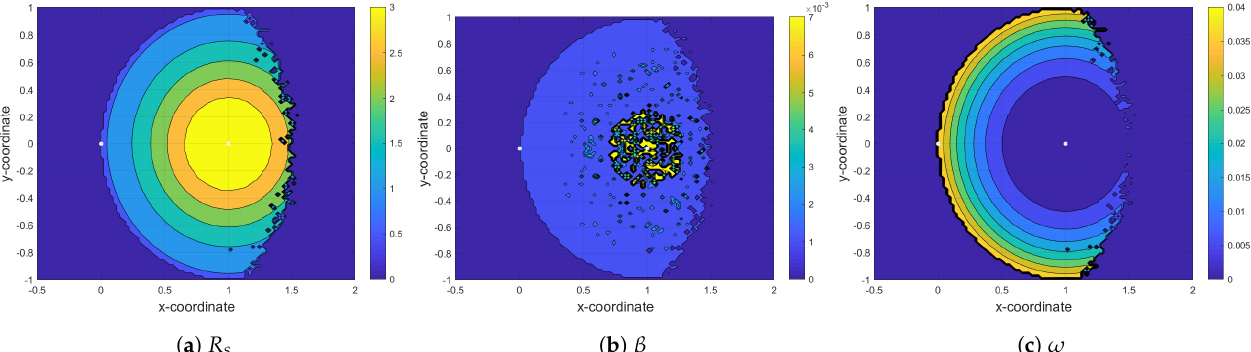
Figure 5. Maximizing rate at the second receiver (SR) by finding the optimum value for time fraction ( β ) and power fraction ( ω ) in the PF-NOMA protocol.